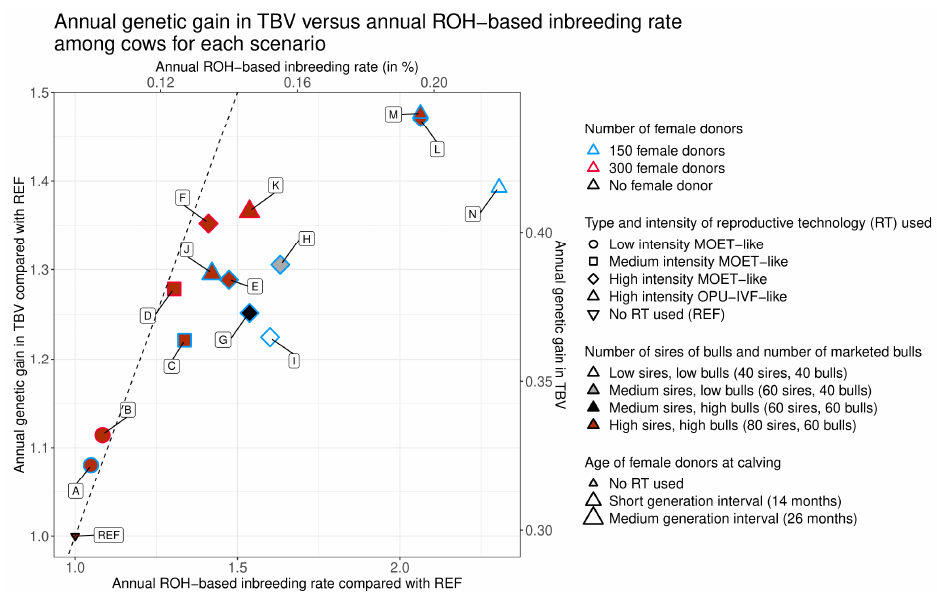
Figure 2. Annual genetic gain versus annual ROH-based inbreeding rate among cows. Letters indicate the names of the tested scenarios. Comparisons with REF were calculated as the ratio between the estimated value of the parameter for a given scenario and the estimated value of the parameter for the reference scenario (no use of embryo transfer). The dotted line is the line of identity between the annual ROH-based inbreeding rate compared with REF and the estimated annual genetic gain in true breeding value compared with REF.